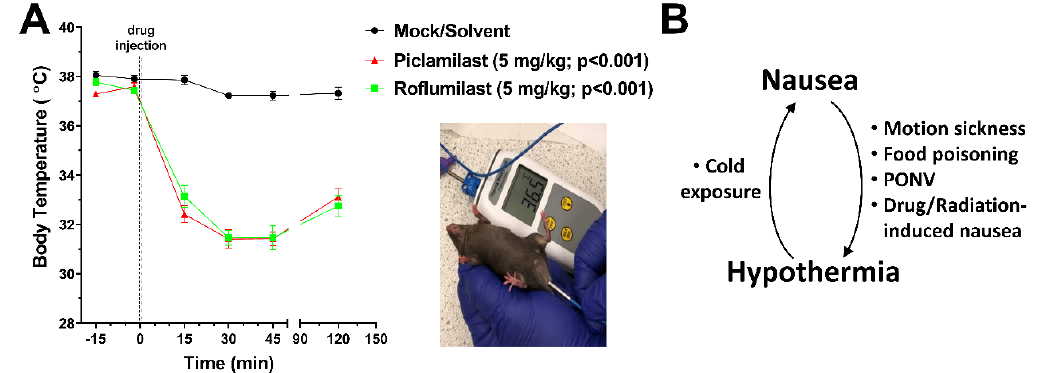
Figure 3. Treatment with PAN-PDE4 inhibitors induces hypothermia. ( A ) The core body temperature of mice was measured at the indicated time points prior to and after injection of the PAN-PDE4 inhibitors Piclamilast/RP73401 and Roflumilast (both 5 mg/kg; i.p.) or solvent control. Data represent the mean ± SEM. Statistical significance was determined using two-way ANOVA with Sidak’s post hoc test. The picture inset illustrates the measurement of core body temperature using a rectal thermometer. ( B ) Scheme illustrating the reciprocal relationship between nausea and hypothermia frequently observed in humans and animals. Nausea induced by motion, poison, surgery/anesthesia (post-operative nausea and vomiting (PONV)), drug- or radiation treatment is frequently accompanied by hypothermia. Conversely, aberrant body temperature regulation (including cold exposure) can predispose to nausea [44,45,47,48].